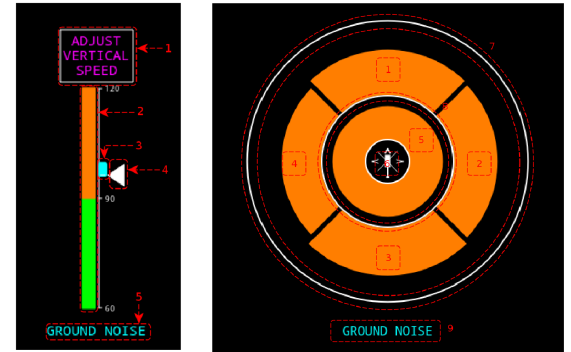
Figure 32: PAI Global Indicator (left) and Directional Indicator